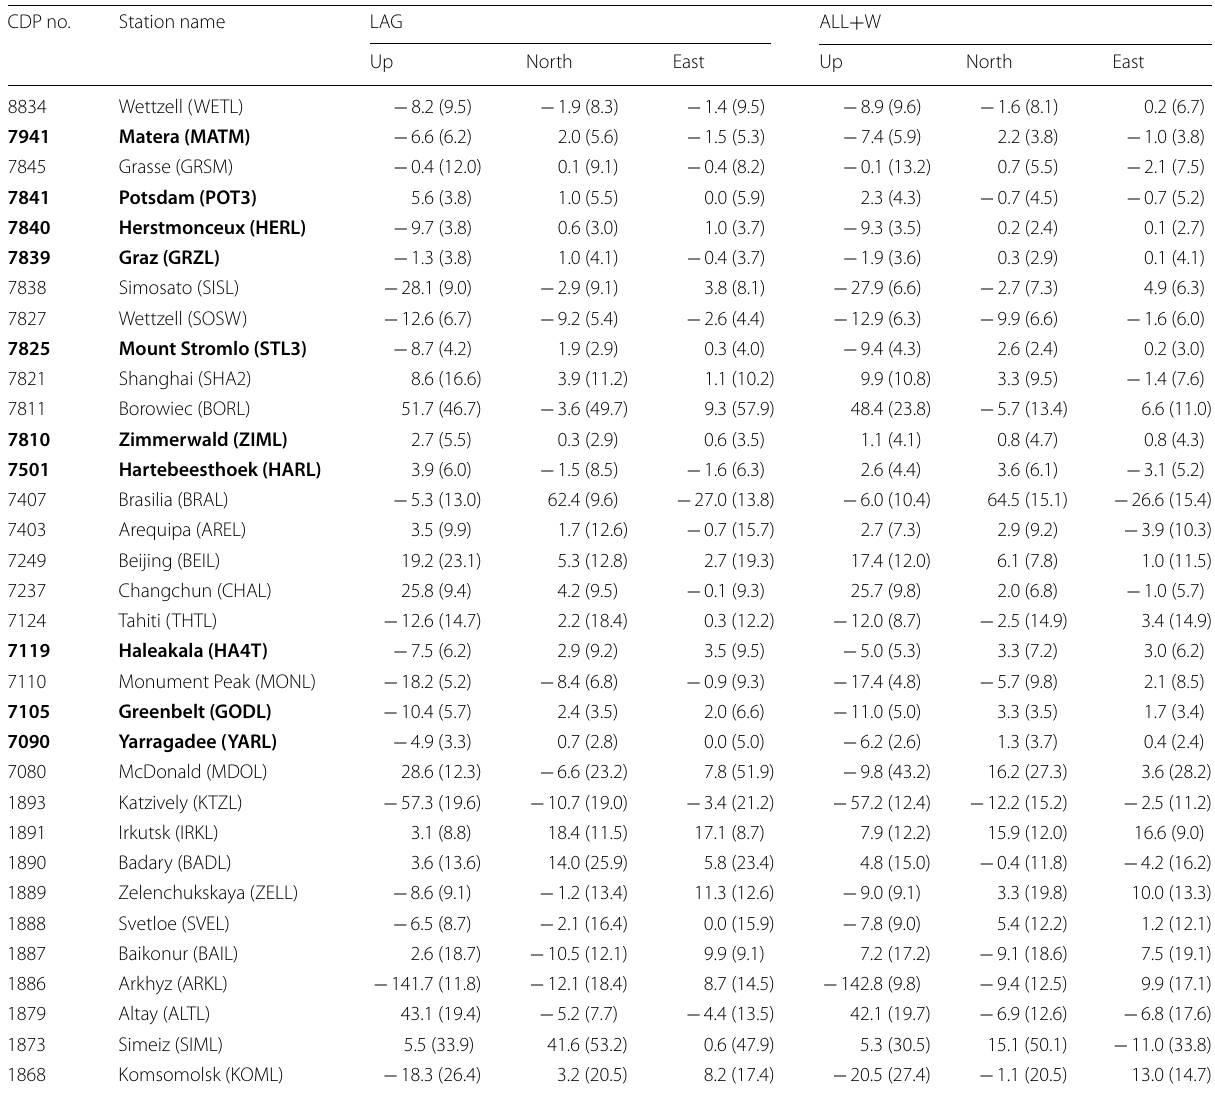
Bolded station numbers and location denote the core stations, IQR are given in parenthesis